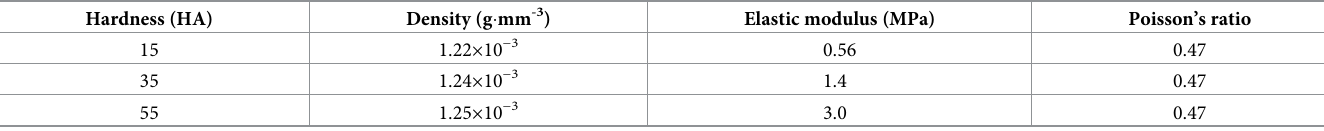
Table 2. Material parameters of silicon rubbers. The densities, elasticity moduli (E) and Poisson’s ratios of silicon rubbers with different hardness degrees. Hardness (HA)